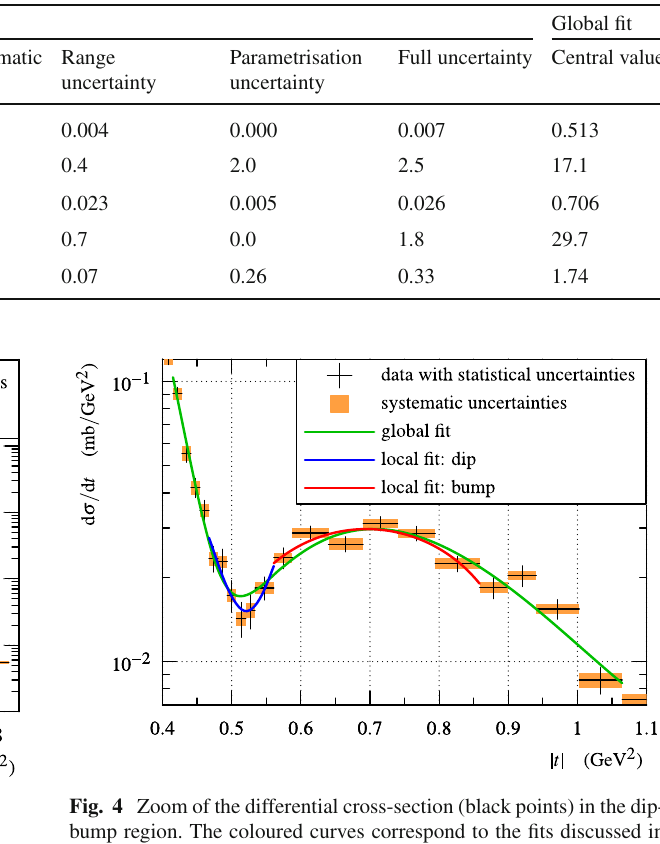
due to the fit parametrisation choice and the full uncertainty (quadratic combination of the preceding four contributions). There are no uncer- tainties quoted for the global fit since it is only used to cross-check the results with an alternative parametrisation